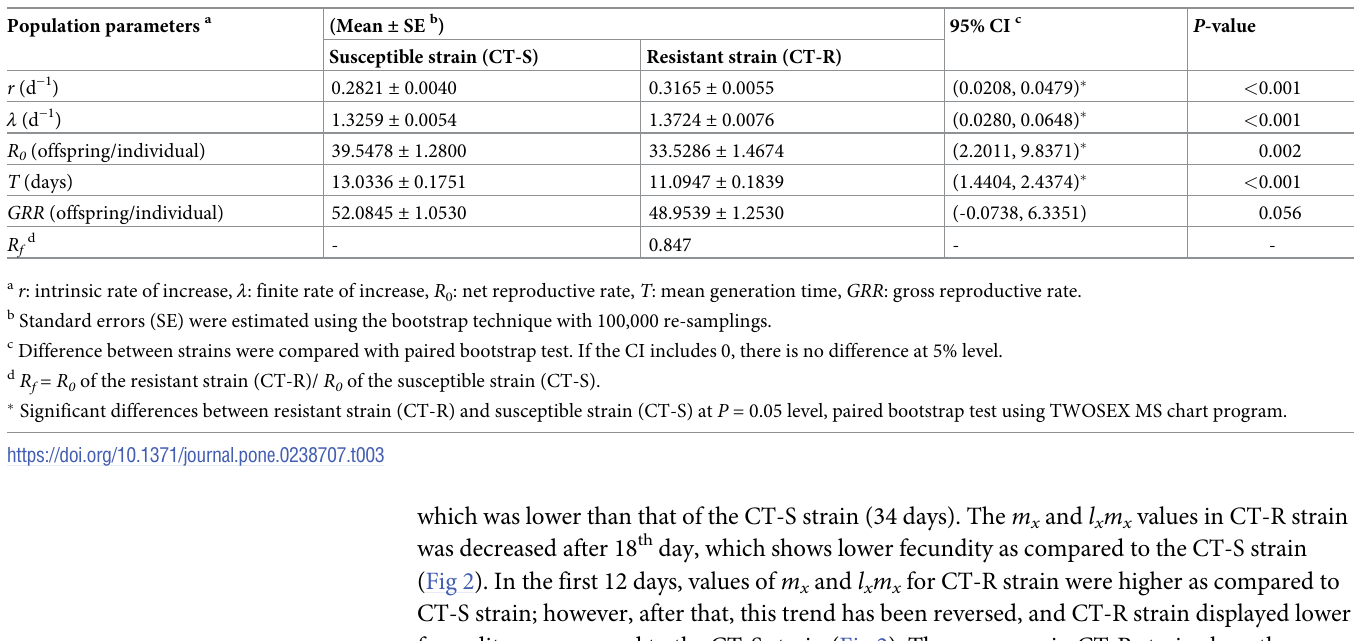
Table 3. Mean ( ± SE) demographic parameters of the susceptible (CT-S) and resistant (CT-R) strains of Aphis gossypii . Population parameters a